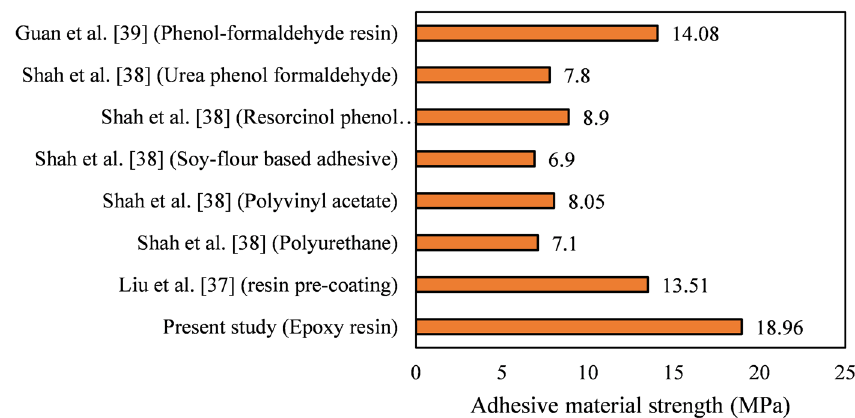
Figure 12: Lap shear test results under di ff erent types of adhesive